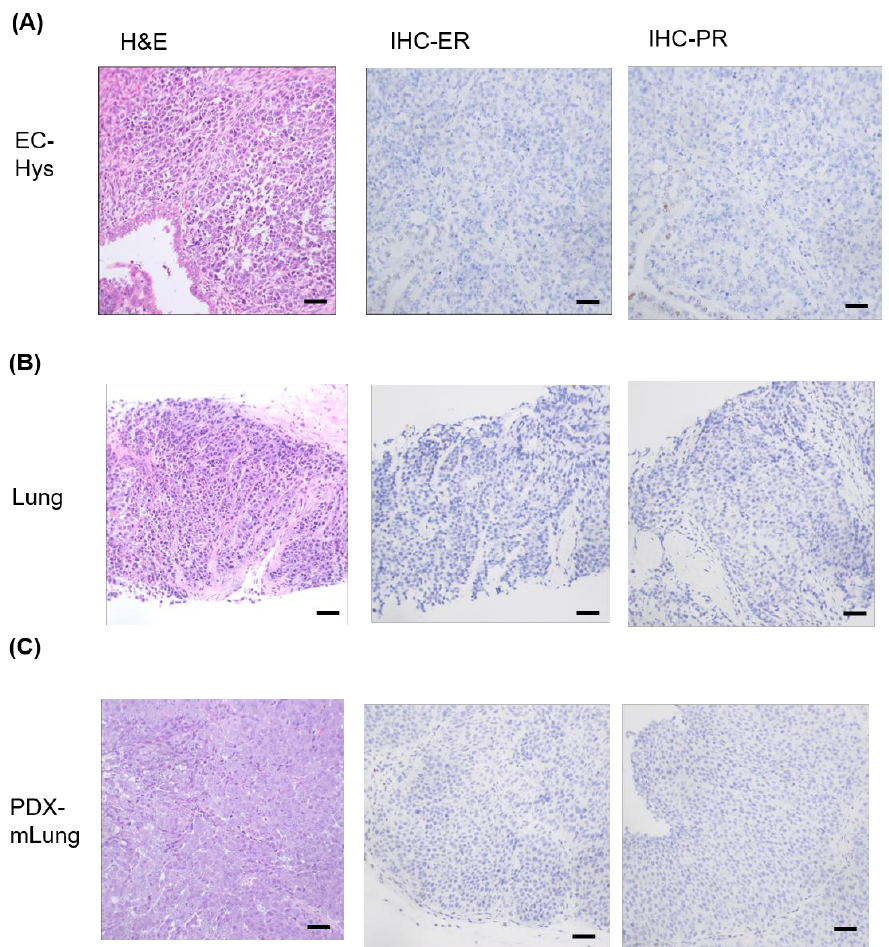
Figure 1. Representative histology images of primary dedifferentiated endometrial carcinoma ( A ) hysterectomy (hys) specimen; ( B ) lung metastasis; and ( C ) PDX-mLung. Hematoxylin and eosin (H&E) staining and results of immunohistochemistry (IHC) for estrogen receptor (ER) and progesterone receptor (PR) expression (Scale bar = 50 μm).